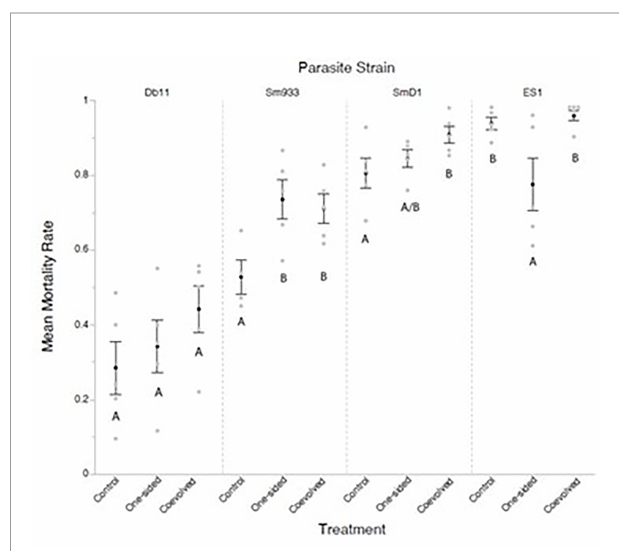
FIGURE 3 | Host Mortality across unrelated parasites. For each mortality assay 200 Worms were exposed to S. marcescens for a period of 48 hours using Serratia Selection Plates. Surviving worms were counted and the mortality is expressed as (worms plated – worms counted)/worms plated). Black circles represent the average mortality rate across all host populations for each bacterial treatment group. White circles represent the average mortality rate across all replicates for one host population. Points which share letters are statistically indistinguishable from each other, and only apply within their respective column. Error bars represent standard error. Letters are differentiated by a =